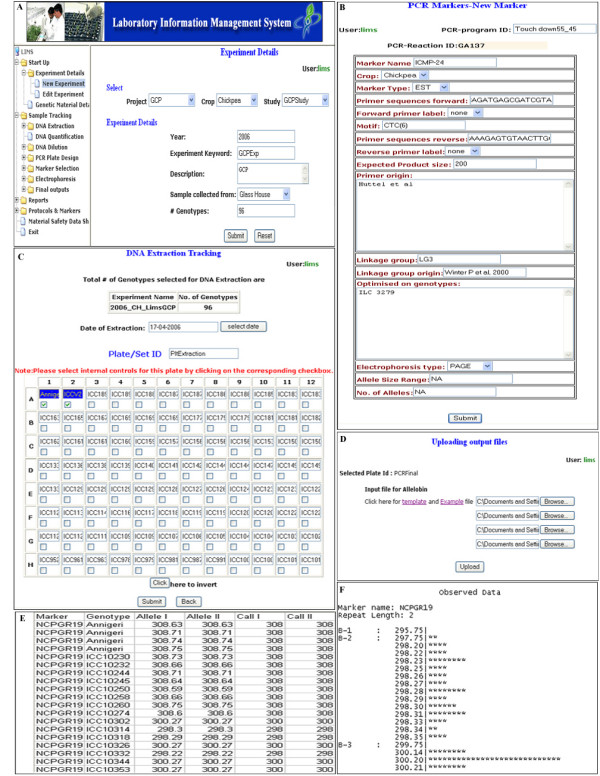
LIMS modules and user interfaces. A: The LIMS user interface for Experimental Design. B: Protocols and Markers – Form uploads for information on markers. C: Reports – sample DNA localization in microtitre plates for DNA extraction. D: Sample Tracking – User interfaces to upload capillary electrophoresis output files. E & F: Output files from the allele-binning program.